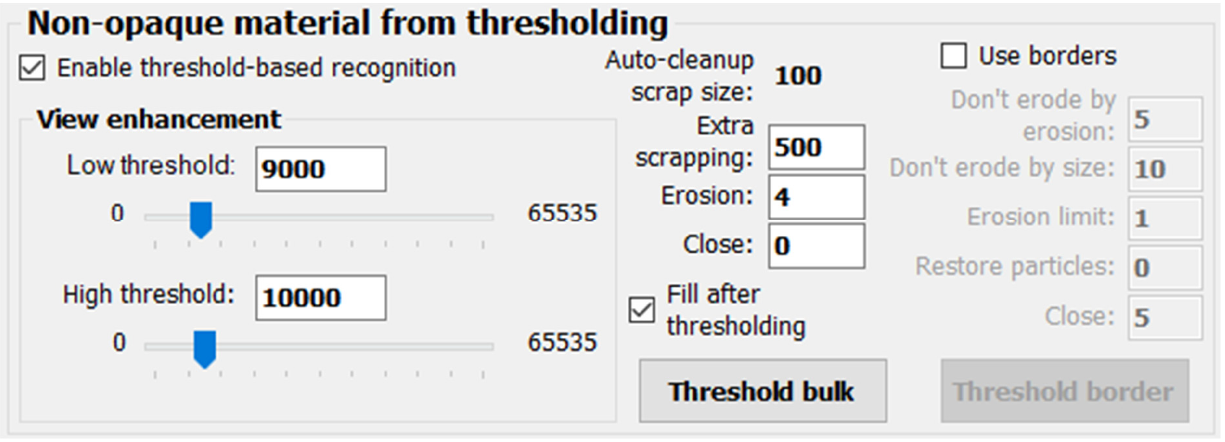
Figure 4. Threshold ‐ based identification frame with “Use borders” section disabled. Figure 4. Threshold-based identification frame with “Use borders” section